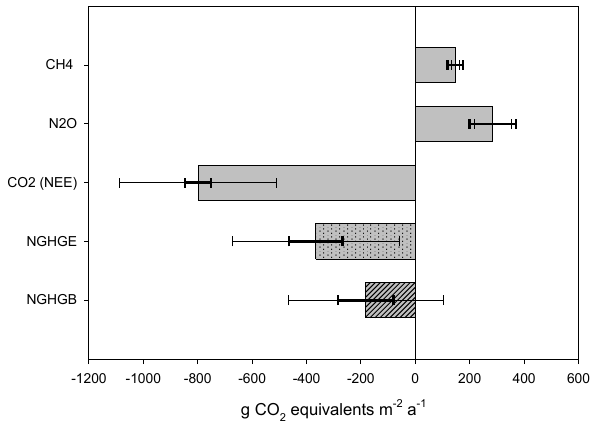
Figure 4. Average greenhouse gas fluxes, net GHG exchange (NGHGE) and attributed net GHG balance (NGHGB, includes FC orgfert , FC animal , FC leaching , FC harvest ) for 2002–2010. Positive values correspond to losses and negative values to storage of green- house gases to and from the grassland system. The CH 4 component comprises CH 4 fluxes from enteric fermentation, animal excretion, slurry application and soil exchange, while the N 2 O component is the N 2 O flux from the soil. CO 2 represents the net ecosystem ex- change (NEE). Global warming potentials of 298 and 25 were used for N 2 O and CH 4 , respectively, using a time horizon of 100 years (Myhre et al., 2013). Thin error bars represent variations (confi- dence intervals at p >0.95) between years, while thick error bars represent the systematic uncertainty of each